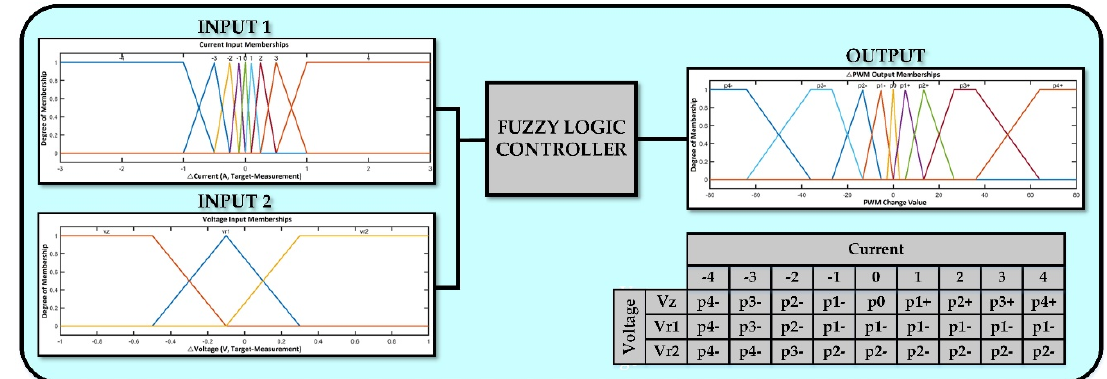
Figure 8. The FLC charge